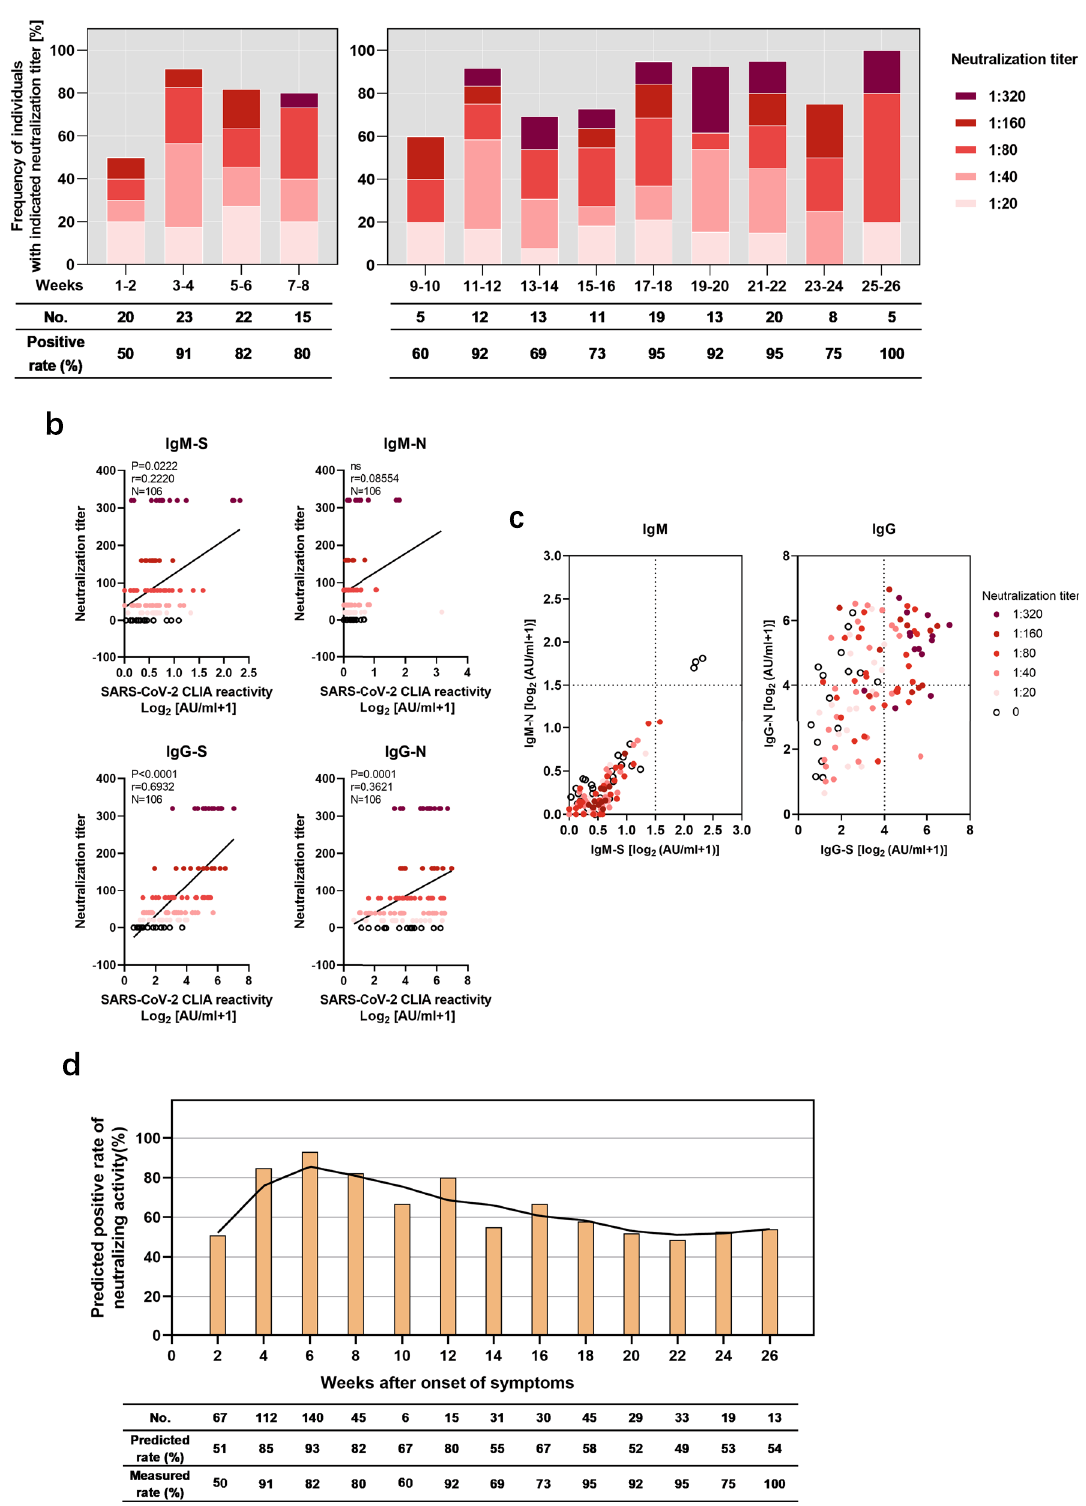
Fig. 3 N-speci fi c and S-speci fi c IgG responses have different predictive values for neutralization. A total of 186 samples from 137 symptomatic COVID- 19 patients were assessed concerning SARS-CoV-2 neutralization titers and grouped according to the weeks after symptom onset. a Proportions of plasma neutralization activity were strati fi ed in 2-week intervals. b Correlation analysis of neutralization titer with S- and N-speci fi c CLIA-reactive IgM/IgG in COVID-19 patients. A nonparametric Spearman ’ s correlation test was used for the statistical analyses. In the graphs, p , r , and n indicate the p value, correlation coef fi cient, and sample size, respectively. c Distribution of neutralizing activity at different S- and N-speci fi c CLIA-reactive IgM/IgG. d based on the predicted cutoff value and IgG-S titer, the neutralizing activity of all con fi rmed patients at different time points was